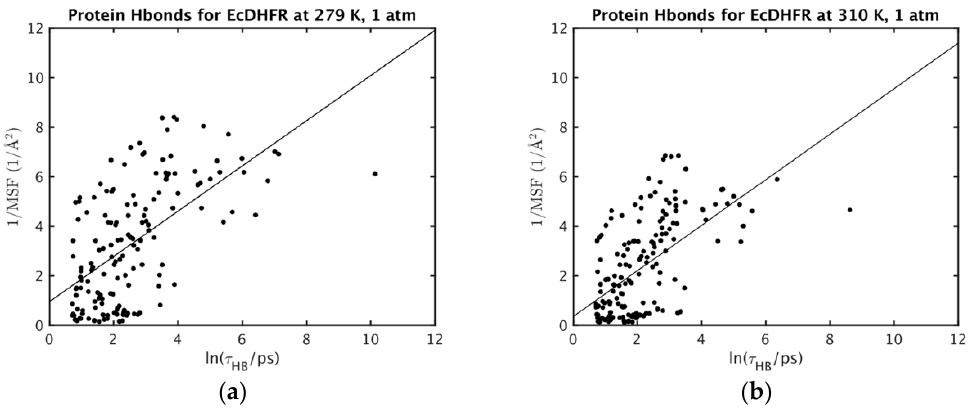
Figure 1. Correlation of inverse atomic fluctuations of hydrogen bond acceptors with the associated hydrogen bond lifetimes longer than 2 ps for EcDHFR at 1 bar and ( a ) 279 K or ( b ) 310 K.